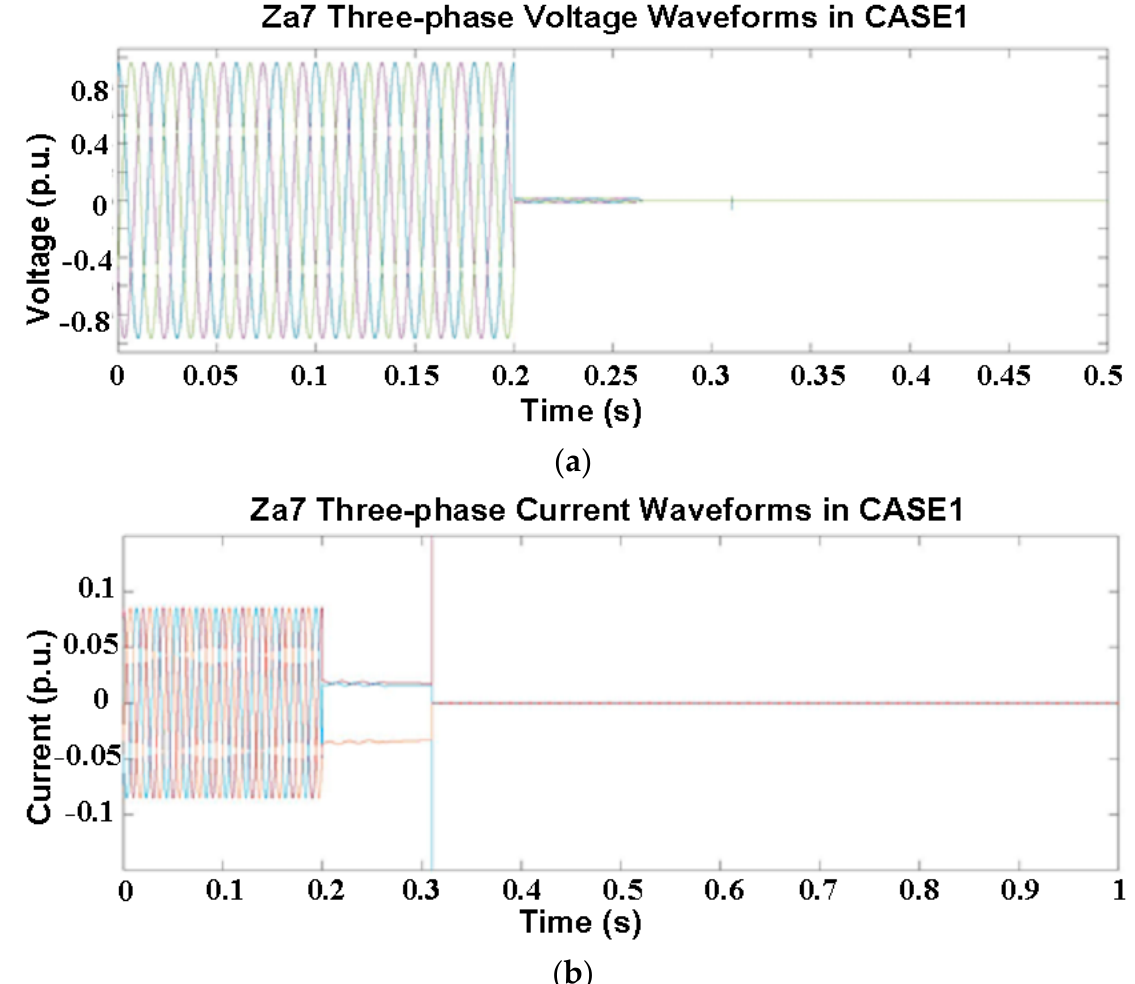
Figure 5. CASE 1 waveforms at Za7 after fault isolation; ( a ) voltage, ( b ) current.